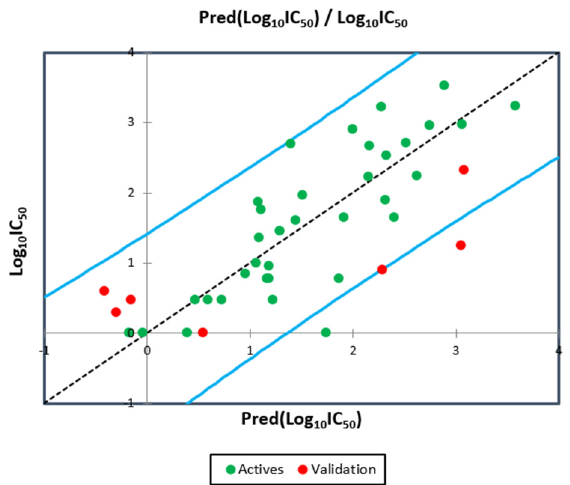
Figure 4. Correlation between the observed and predicted activities using MLR technique.